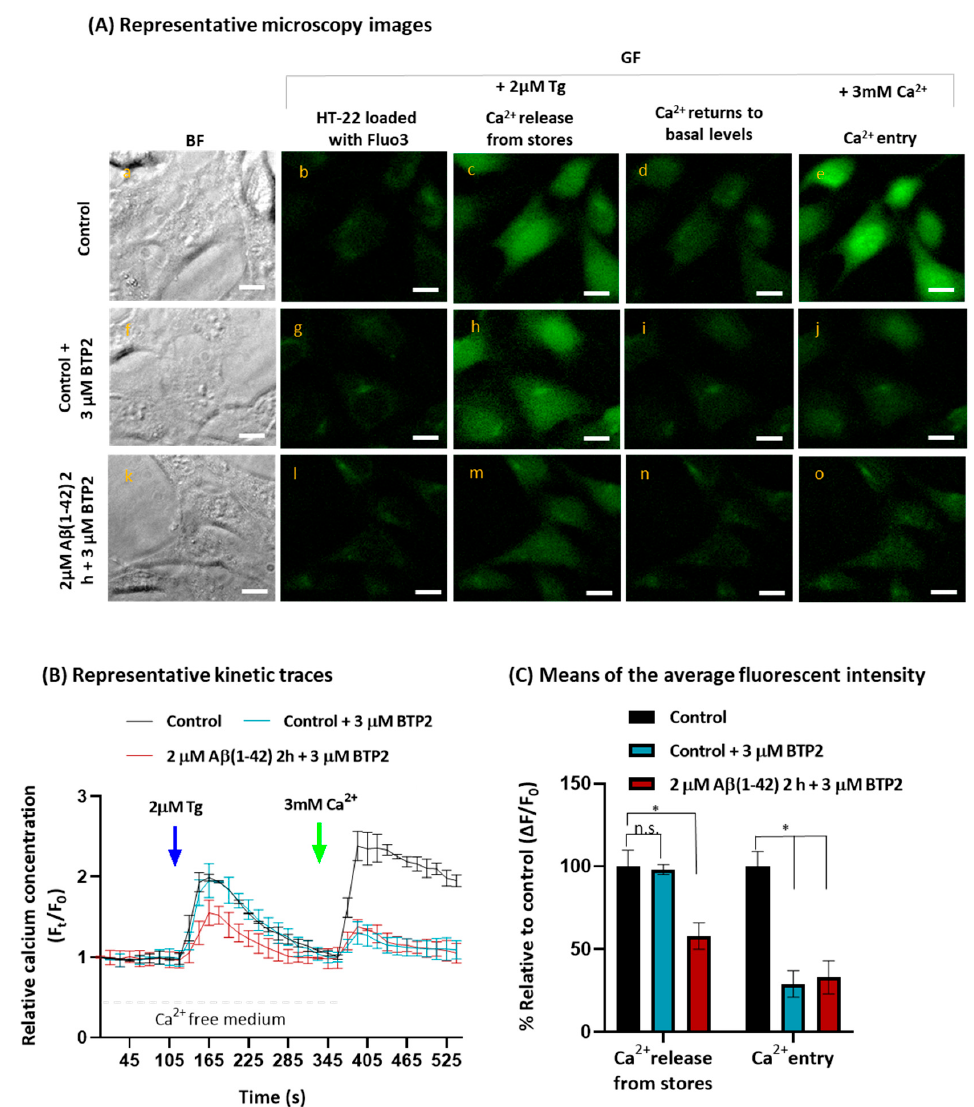
Figure 3. Effect of the SOCE inhibitor BTP2 in untreated (control) and treated HT-22 cells with A β (1-42). Untreated HT-22 cells (control) and treated cells with 2 µ M A β (1-42) for 2 h were incubated with 3 µ M of BTP2 for 15 min at 37 ◦ C. Panel ( A ): representative fluorescence microscopy images of untreated HT-22 (control), cells with 3 µ M BTP2, and cells treated with A β (1-42) plus 3 µ M BTP2. (a,f,k) Bright field images (BF) of the fields selected for fluorescence images of Fluo3-loaded cells obtained before addition of 2 µ M Tg (b,g,l), at the peak fluorescence after the addition of Tg (c,h,m), after completion of the Ca 2+ release from the ER (d,i,n), and at the peak fluorescence after the addition of 3 mM Ca 2+ (e,j,o). Scale bar = 20 µ m. Panel ( B ): representative kinetic traces of HT-22 control with (blue trace line) or without BTP2 (black trace line) and HT-22 cells incubated with 2 µ M A β (1-42) for 2 h plus BTP2 (red trace line) after addition of 2 µ M Tg (indicated by the blue arrow) for Ca 2+ release from stores, and addition of 3 mM Ca 2+ to evaluate the extension of Ca 2+ entry in HT-22 cells (indicated by the green arrow). Panel ( C ): means of the average fluorescent intensity ( ∆ F/F 0 ) represented by percentage (%), relative to control cells. BTP2 does not elicit ER Ca 2+ depletion but inhibits the Ca 2+ influx in 71 ± 8% in control cells and HT-22 cells incubated with 2 µ M A β (1-42) for 2 h, compared with the respective controls. Data are presented as the mean ± SEM of experiments done at least in 10 Petri plates in 5 independent assays (n > 80 cells for each condition) (* p < 0.05, relatively to each control).